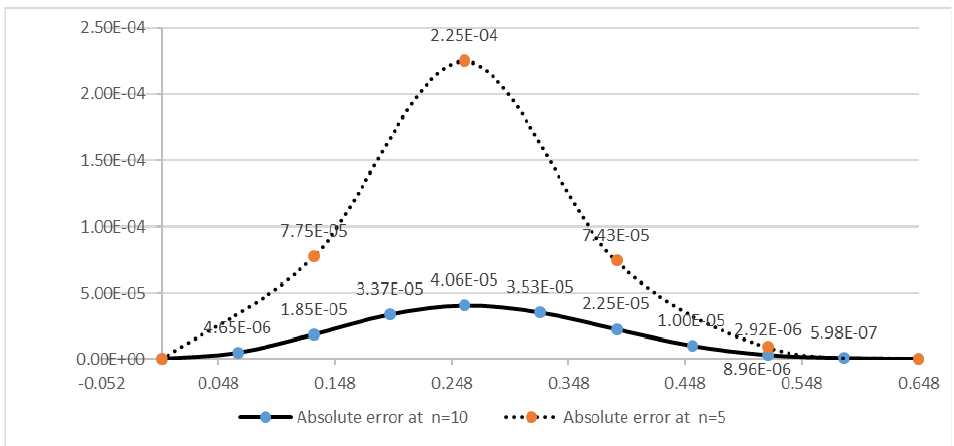
Figure 5. Problem 2 at h = 0.064872 and h = 0.12974426.